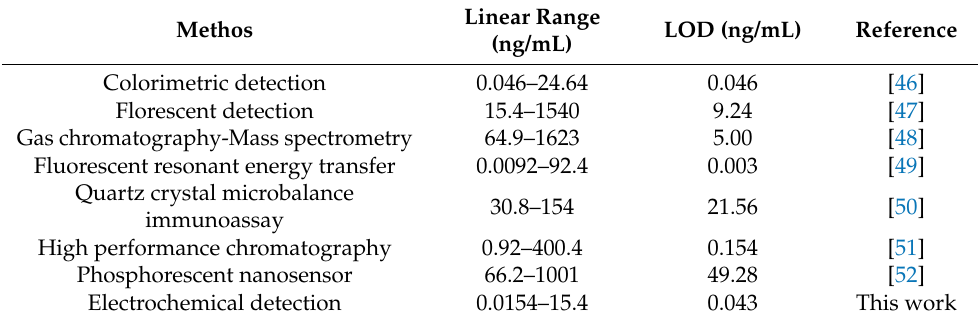
Table 1. Comparison of different methods for the determination of PAT. Methos